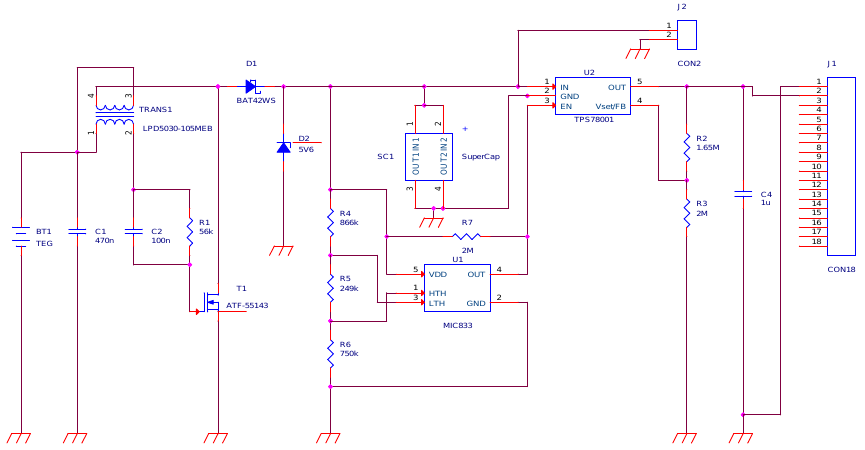
Figure 2. Electronic diagram of the conditioning hardware circuit that converts and stores the energy generated by the TEG, and supplies the